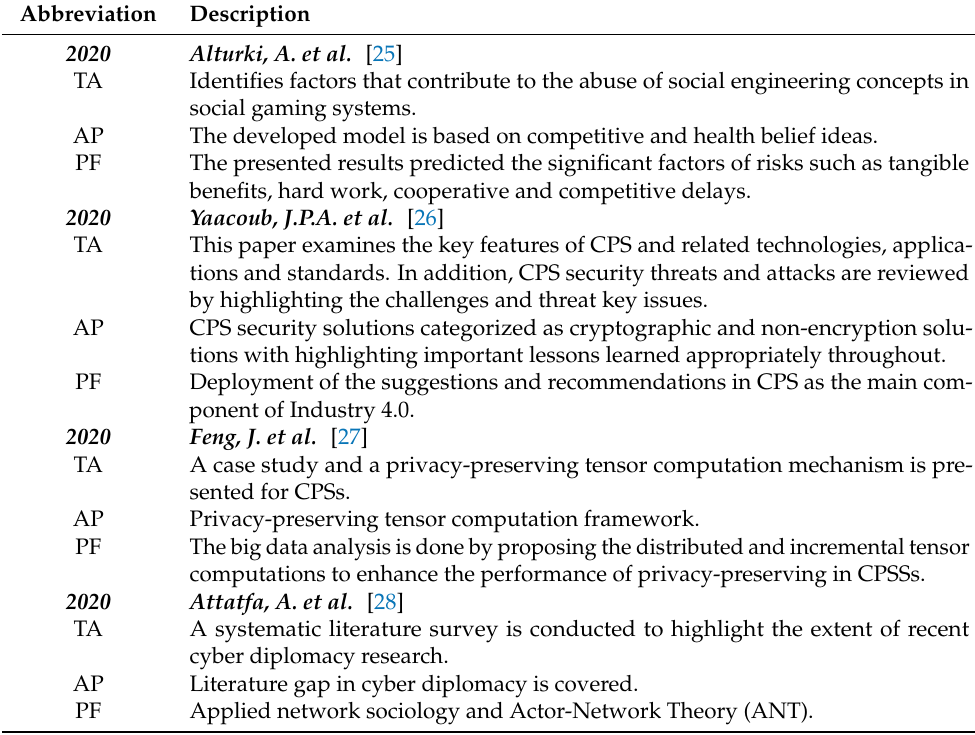
Table 2. Recent Survey on Social and Medical Systems Cyber